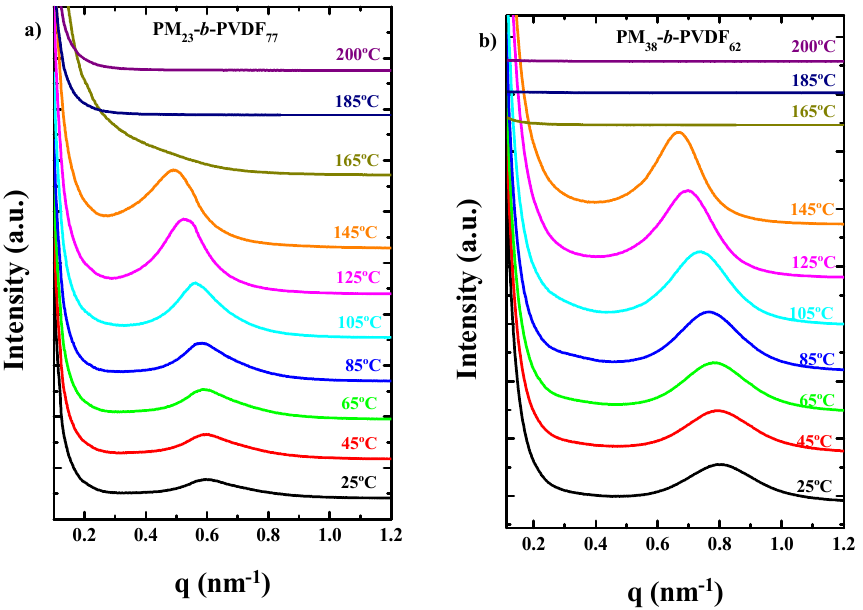
Figure 1. SAXS analysis at different temperatures during heating scans at 20 °C/min after a cooling process also at 20 °C/min of ( a ) PM 23 - b -PVDF 77 sample and ( b ) PM 38 - b -PVDF 68 sample. PLOM was used to observe the crystallization process in the different samples and to check if the segregation behavior is different between block copolymers and blends.